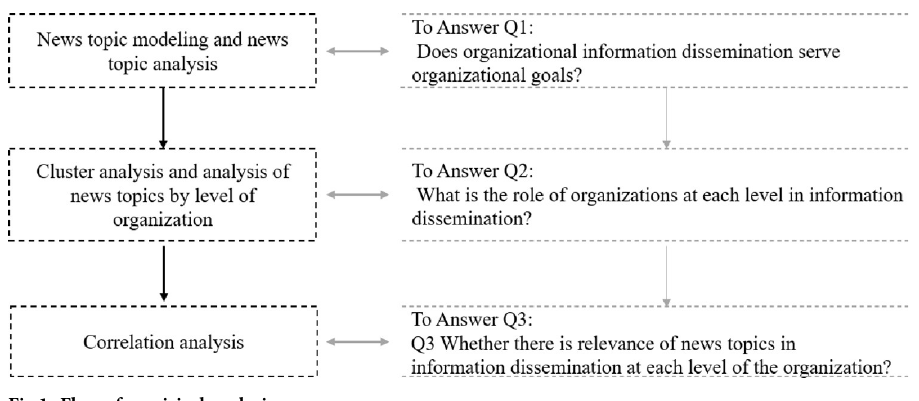
Fig 1. Flow of empirical analysis.